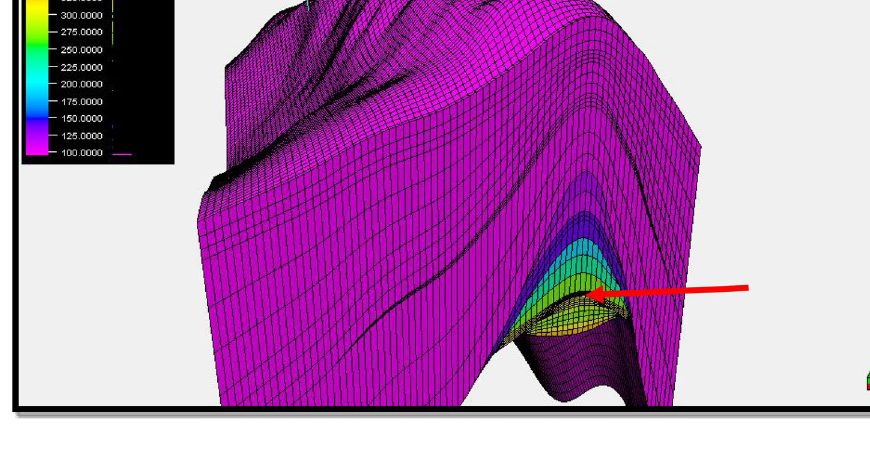
Fig. 21 Predicted pore pressure (red arrow pointing to the prob- lematic overpressured area)